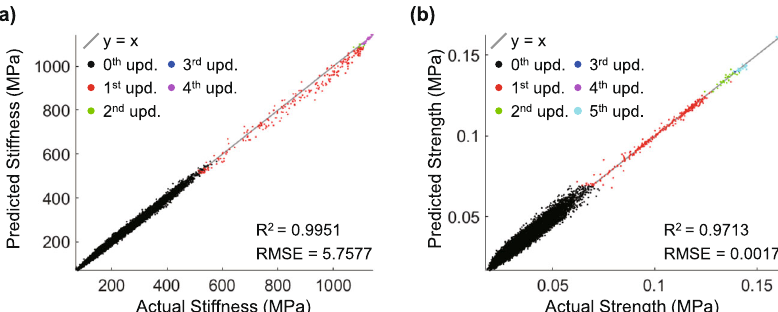
Fig. 5 Designing progress plot. Designing progress plot for maximum ( a ) stiffness and ( b ) strength. The values are predicted from DNN trained at the last update. The data obtained from each iteration are represented with a different color.